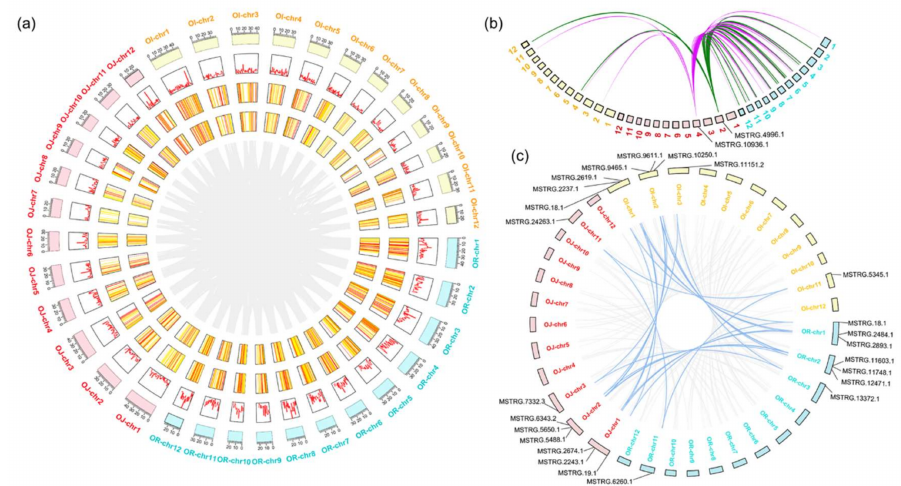
Figure 4. Circos plots of sequence conserved and positionally conserved lncRNAs that may be associated with rice domesti- cation. ( a ) Distribution of sequence-conserved lncRNAs between O. rufipogon , japonica and indica . The 12 chromosomes in each set are shown in the outermost circle. Red lines in the second circle indicate the density of lncRNAs detected in this study. Heatmaps in the third and fourth circles represent the expression level of sequence-conserved lncRNAs in panicles and seedlings, respectively. The internal links in gray connect lncRNAs that are sequence-conserved between O. rufipogon , japonica and indica. ( b ) Two examples showed multiple lncRNAs in wild rice are sequence-conserved with rare lncRNAs in cultivated rice. Purple lines indicate 41 lncRNAs in O. rufipogon are homologous with 1 and 3 lncRNAs in japonica and indica , respectively. Green lines indicate 21 lncRNAs in O. rufipogon are homologous with 1 and 2 lncRNAs in japonica and indica , respectively. ( c ) Circos representation of positionally conserved lncRNAs between O. rufipogon , japonica and, indica . Links depicted conserved synteny of lncRNAs between at least two genomes, with blue lines highlighting the eight positionally conserved lncRNA-matches between O. rufipogon , japonica , and indica